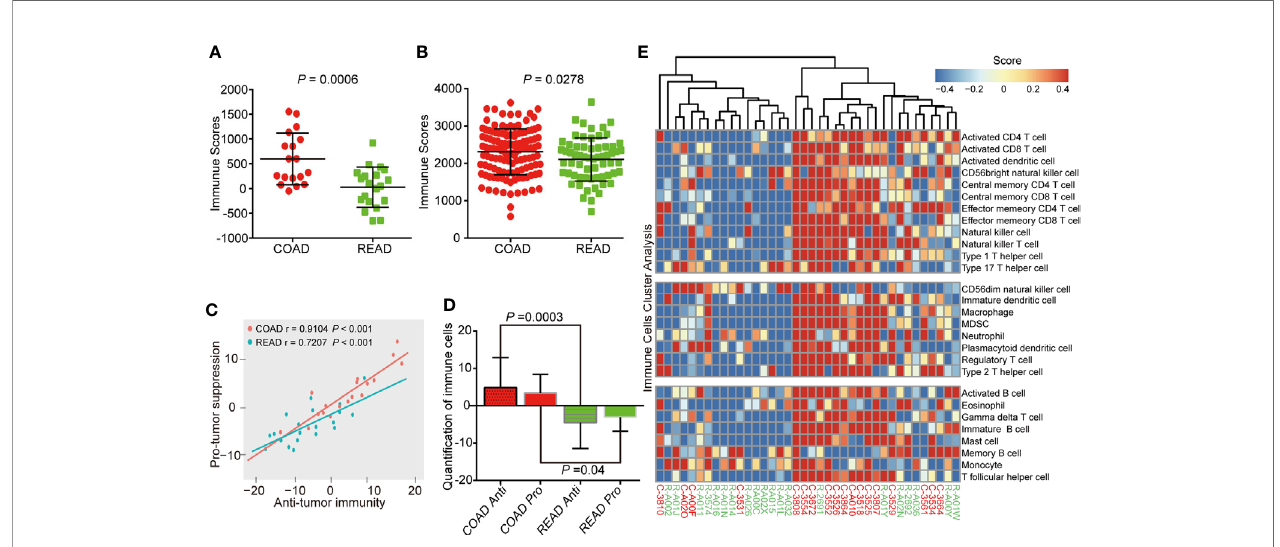
FIGURE 3 | Colon adenocarcinoma (COAD) has higher immune score than rectal adenocarcinoma (READ). (A) Immune scores analysis showing that COAD had higher immune scores than READ in protein level, as analyzed by proteomics of 38 clinical samples. (B) COAD exhibited higher immune scores than READ in mRNA level of 238 samples (172 COAD and 66 READ). (C) Correlation between in fi ltration of cell types executing anti-tumor immunity and cell types executing pro-tumor, immune suppressive functions in COAD and READ. r coef fi cient of Pearson ’ s correlation. (D) The quanti fi cation of both pro-tumor suppression (Pro) and anti-tumor